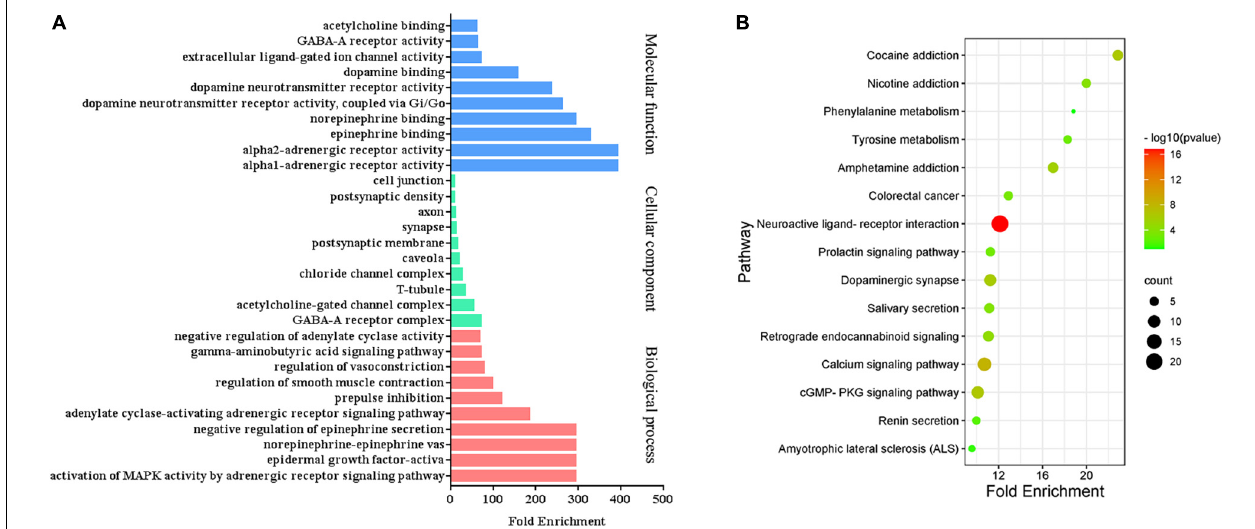
FIGURE 3 | Clustering analysis of possible targets of candidate Chinese herbal medicine (CCHM) in the treatment of methamphetamine (METH) addiction. (A) Gene ontology (GO) analysis of the possible targets. (B) Kyoto encyclopedia of genes and genomes (KEGG) enrichment analysis of the possible targets. Counts referred to the number of the enriched targets.